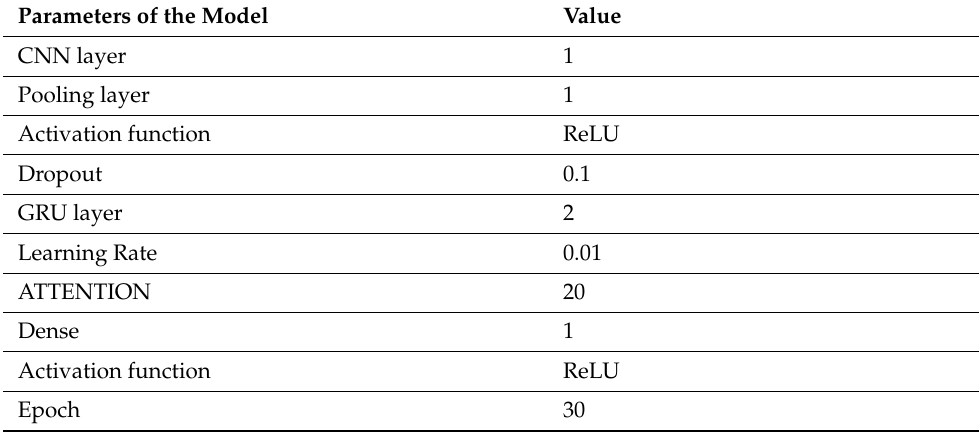
Table 1. Spanish Wind Power Dataset Model